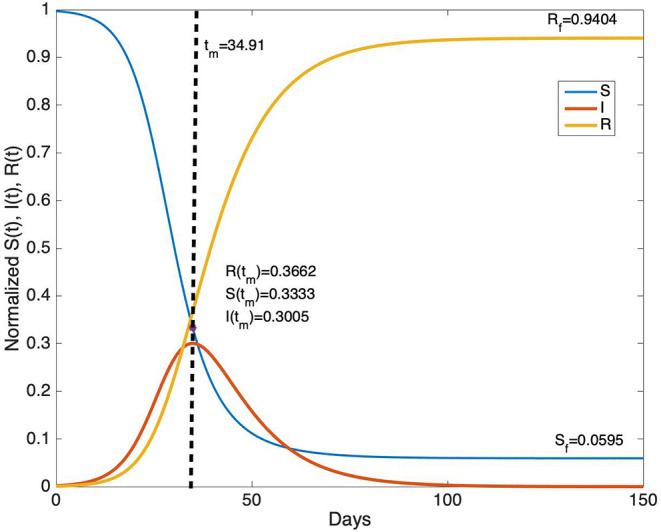
The time evolution of S(t), I(t), and R(t) for ℜ0= 3, T = 10 days and R(0) = 10−3.